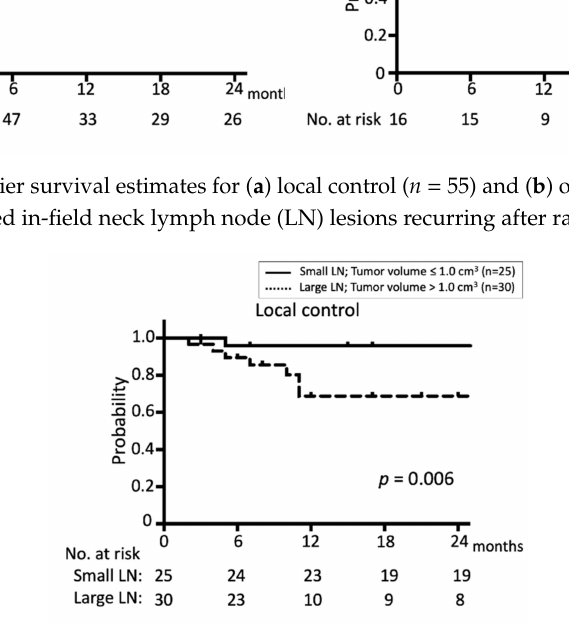
Figure 2. Kaplan–Meier survival estimates for local control or CyberKnife-treated in-field neck LN lesions recurring after radiotherapy stratified by target volume, i.e., ≤ 1.0 cm 3 ( n = 25) vs. > 1.0 cm 3 ( n = 30). Table 2. Analysis of prognostic factors for local control rate after